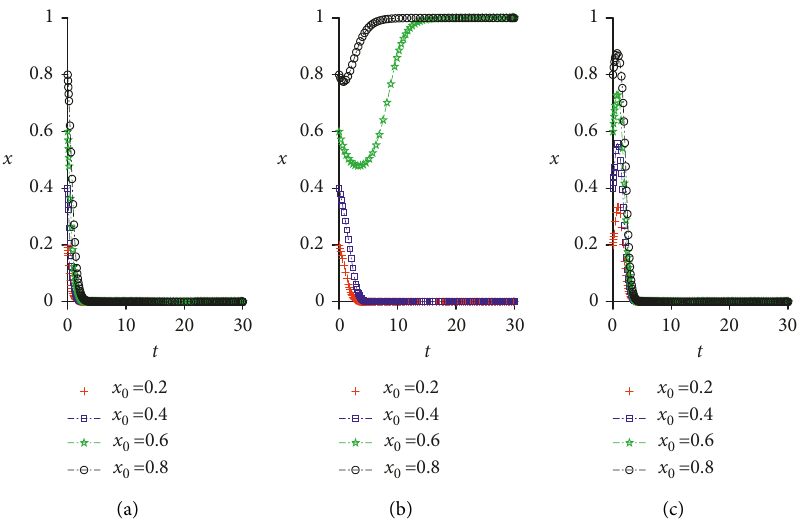
Figure 11: Impact of μ on system evolution. According to (b), when the benefit distribution proportions of the two parties are equal, the system may evolve to the ideal or worst state, while according to (a) and (c), when one party’s benefit distribution proportion is much smaller than that of the other, the system will evolve to the worst state. (a) μ